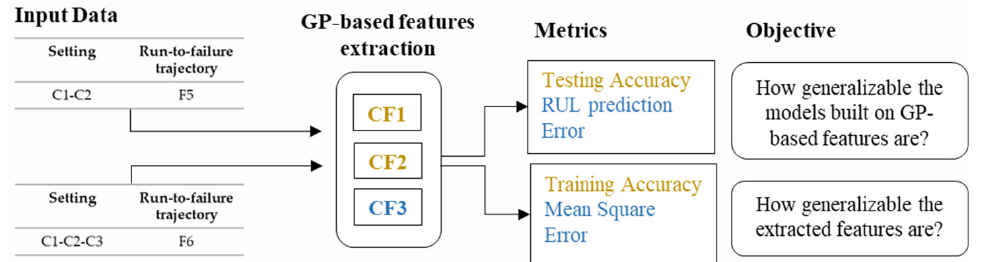
Figure 3. Framework for GP-based feature evaluation (testing). Table 5. Extracted time features from raw signals. , is the signal (observation) at time , = 1, … , , is the length of the signal segments, are third and the fourth moment of , = 1 … , respectively.